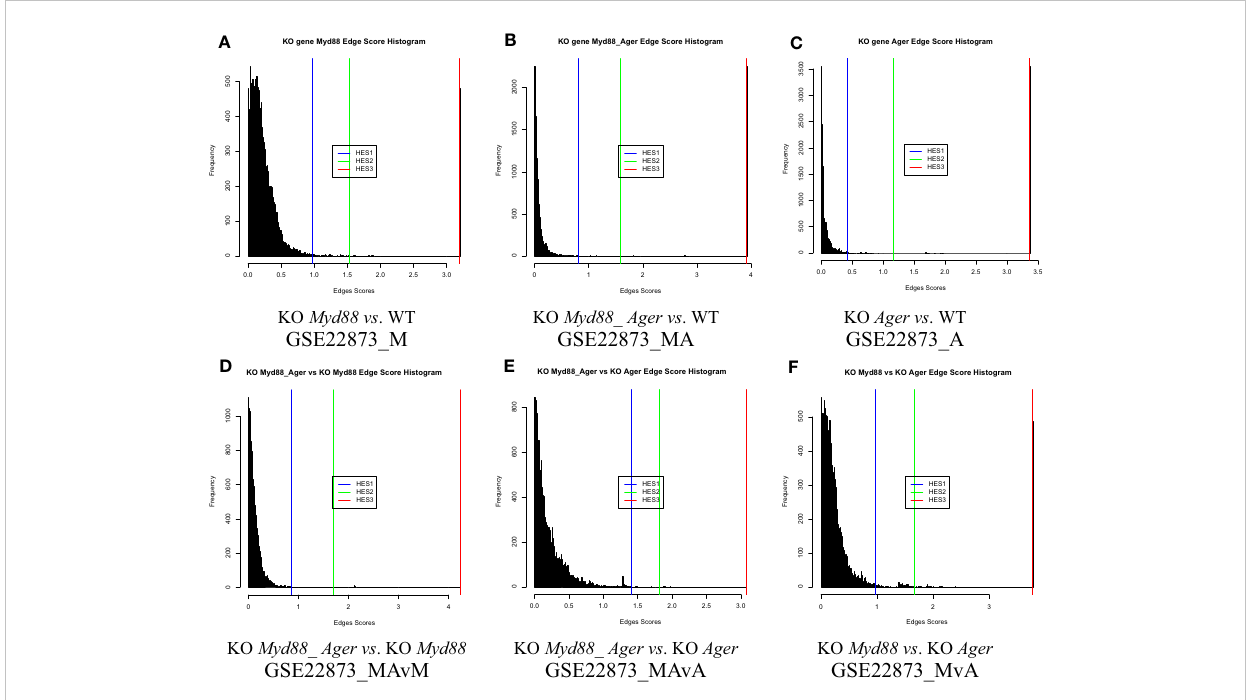
FIGURE 4 The distribution of edge scores with drastic variations among data. (A) GSE22873_M; (B) GSE22873_MA; (C) GSE22873_A; (D) GSE22873_MAvM; (E) GSE22873_MAvA; (F)